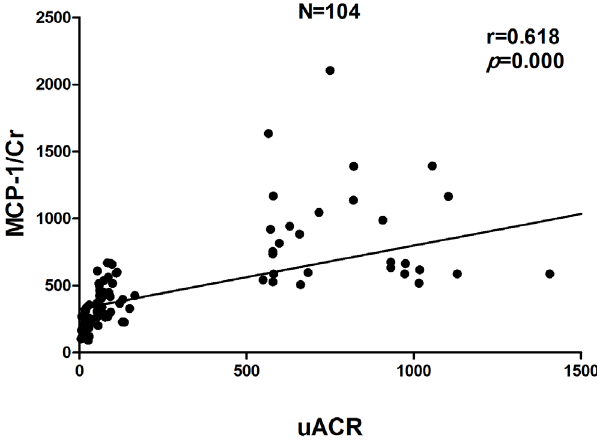
Figure 6. Correlation between urinary MCP-1 excretion rate and